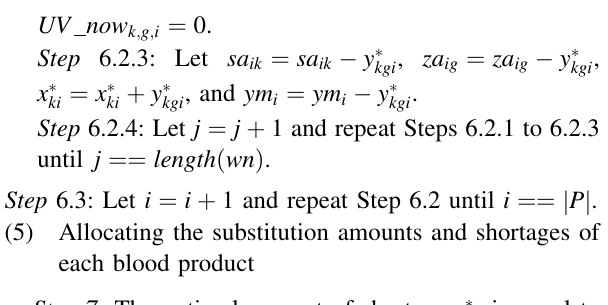
Table 4 Red blood cell demand from each blood bank in the Wenchuan Earthquake affected area (U) Blood Groups Blood Banks a AB ? AB - B